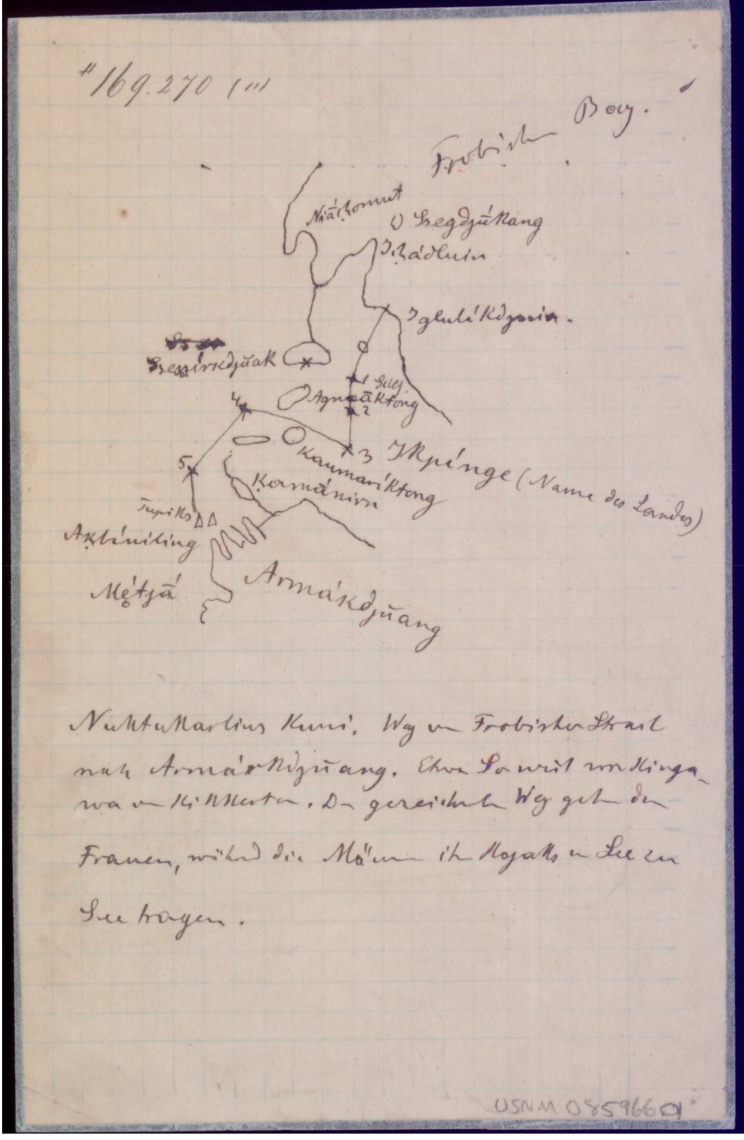
Figure 3. Map by anonymous Inuit and annotations by Franz Boas. Downloaded from the National Anthropological Archives of